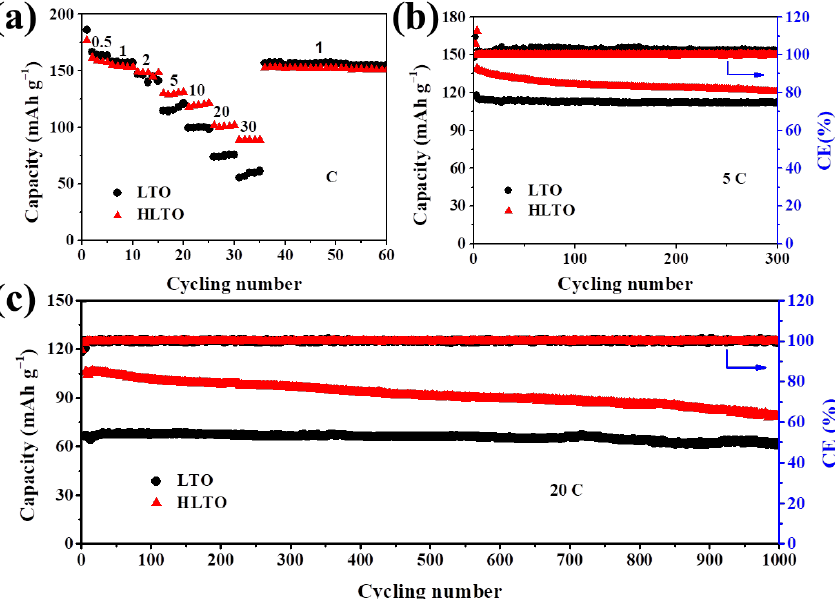
Figure 4. Electrochemical tests of LTO and HLTO: ( a ) Rate performance; ( b ) Cycling performance at 5 C; ( c ) Long-term cycling stability test at 20 C. All the capacities displayed in this figure are the discharge capacities.